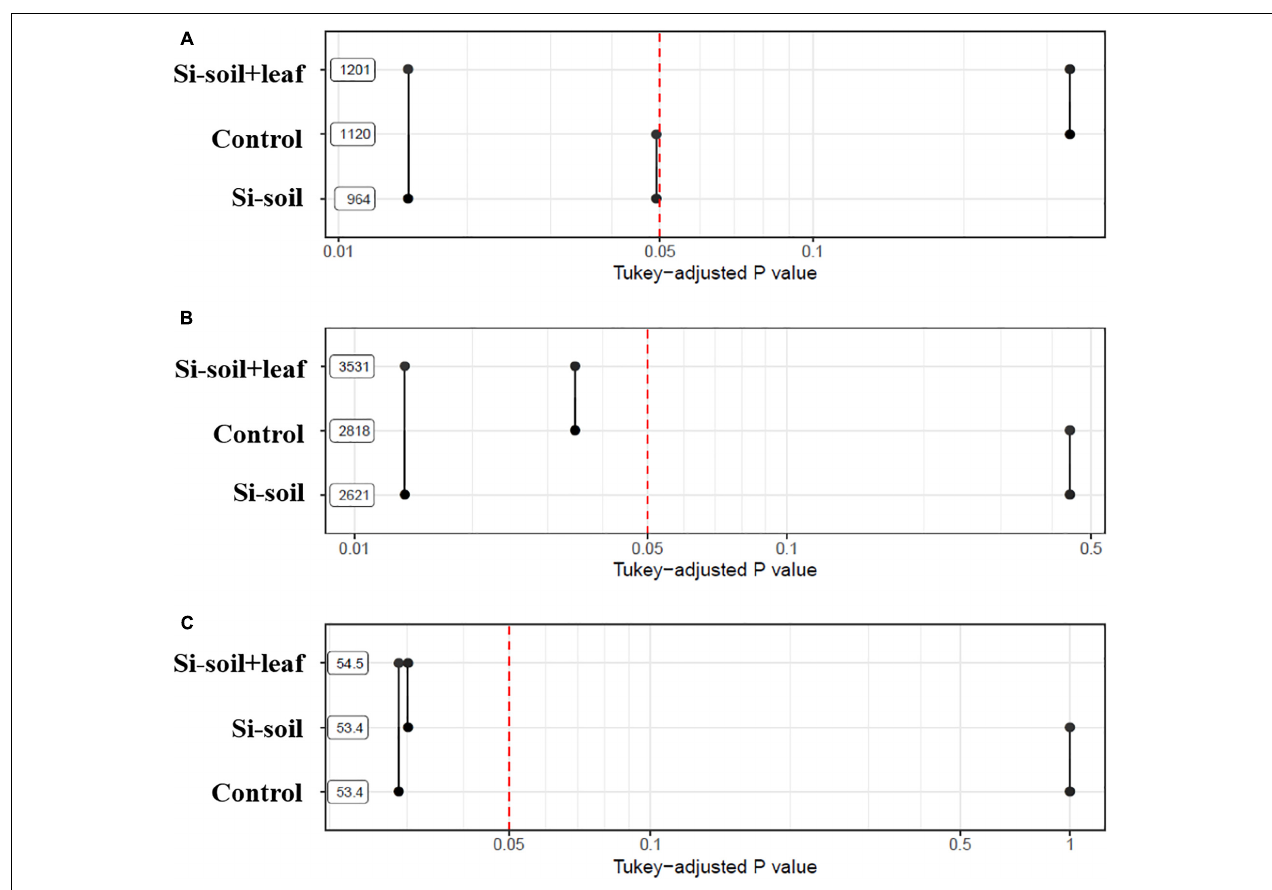
FIGURE 8 | P -values associated with pairwise comparisons of means of treatments for length (A) , number of forks (B) , and average link angles (C) . TABLE 3 | Correlation network plot between phenotypic data obtained by image analysis and root architecture data. Number of nodules Root length Number of forks Average link